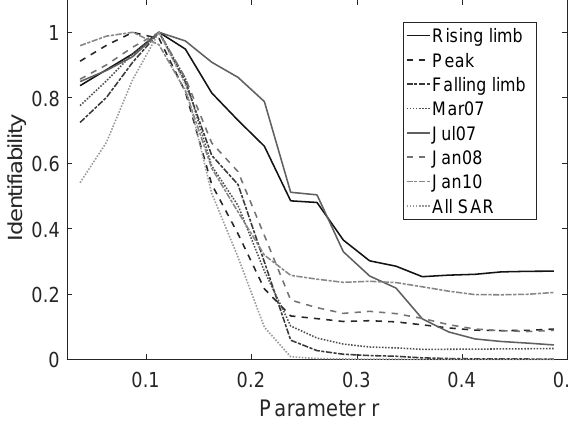
Figure 7. Identifiability against r parameter for different stages in hydrograph.